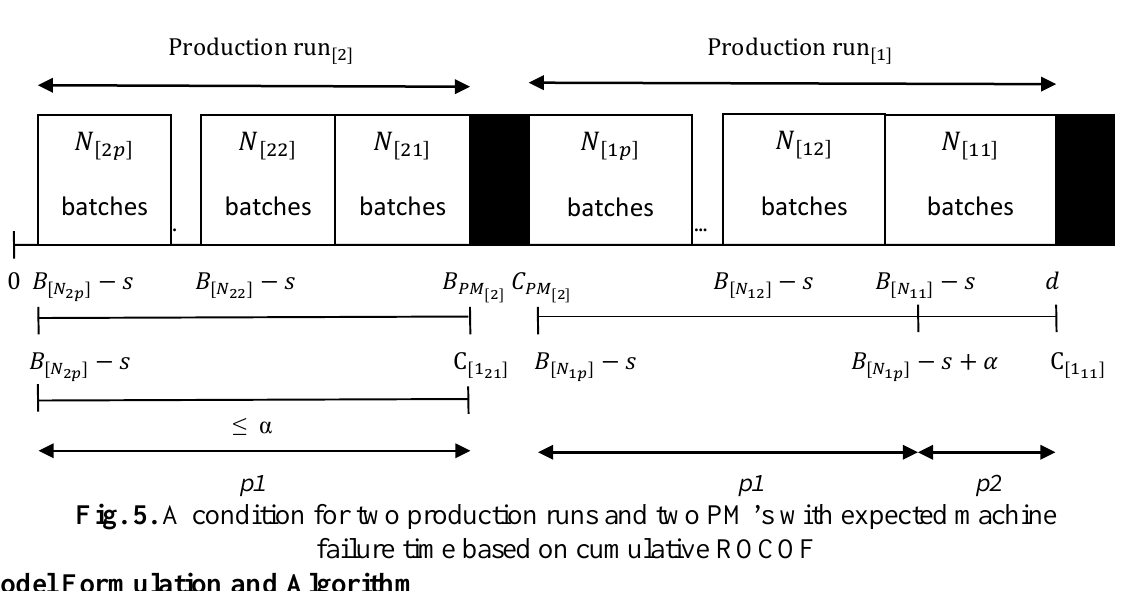
Fig. 5. A condition for two production runs and two PM’s with expected machine failure time based on cumulative